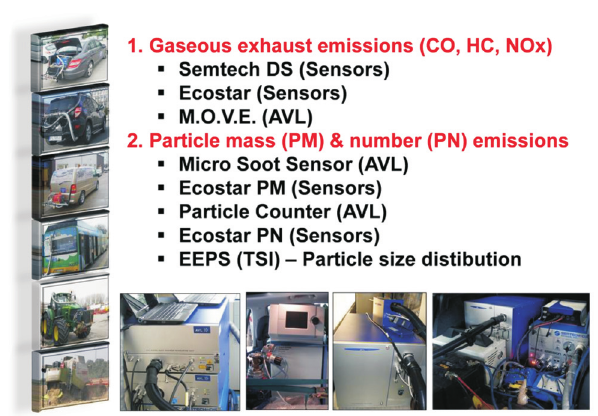
Fig. 7. Example applications of the PEMS equipment (PEMS compo - nents listed)